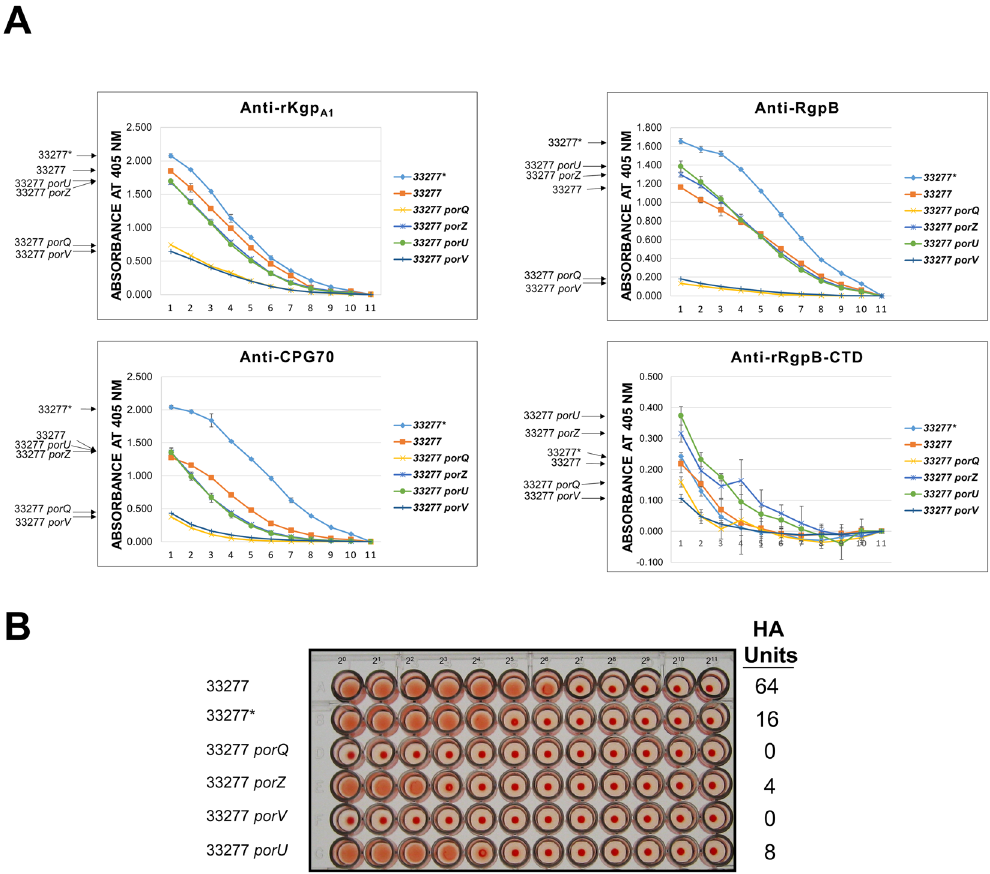
Figure 4. Secreted T9SS substrates are reduced but still present on the surface of the PorZ mutant. ( A ) Whole cell ELISAs. Starting antisera dilutions (dilution 1) for serial 2-fold dilutions for points 1–10 were 1/200 (anti- rRgpB CTD) or 1/400 (anti-RgpB, anti-rKgpA1 and anti-CPG70). Point 11 represents secondary anti-mouse IgG horse radish peroxidase conjugate only controls to which all values were normalised for each strain. Signal intensity order for strains are indicated on left hand side of figure. ( B ) Haemagglutination assays. Two fold serially diluted bacterial suspensions were mixed with an equal volume of 1% (v/v) erythrocyte suspension in U bottom microtitre plates and photographed after 3 h incubation at room temperature. Haemaggutination units were calculated per 50 µ l of starting cells and are indicated on the right hand